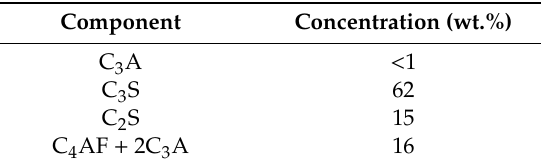
Table 4. Saudi class G cement phase composition.